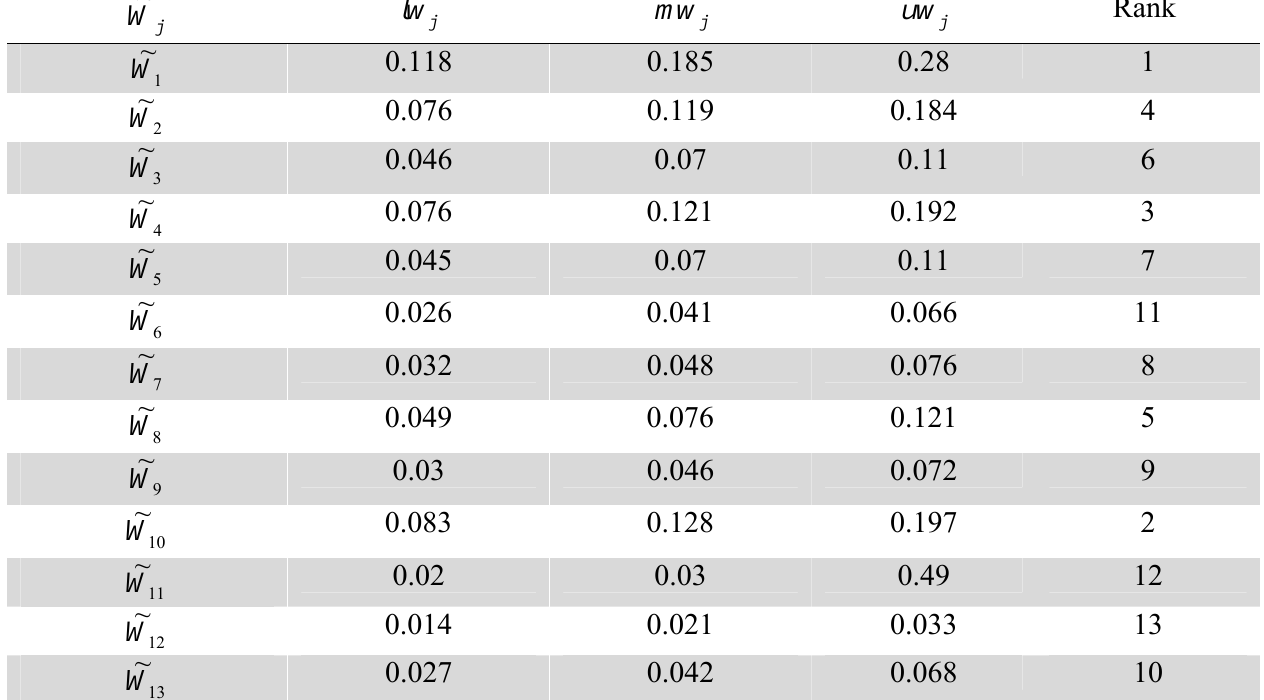
The summary of ranking seven criteria based on VIKOR method for electronic green supply chain